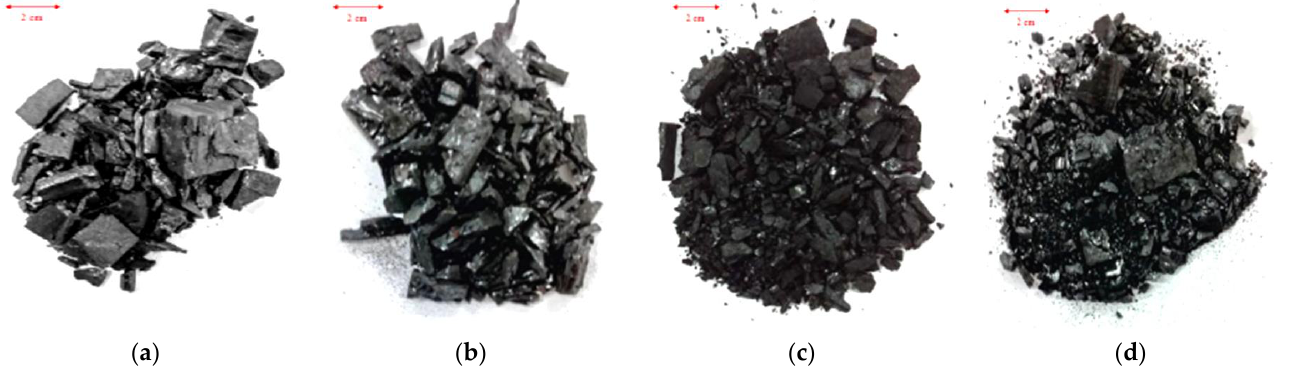
Figure 6. Failure morphology of coal specimens under differential dynamic impact velocities before sieving. ( a ) v = 2.675 m·s −1 . ( b ) v = 3.275 m·s −1 . ( c ) v = 4.024 m·s −1 . ( d ) v = 5.011 m·s −1 .